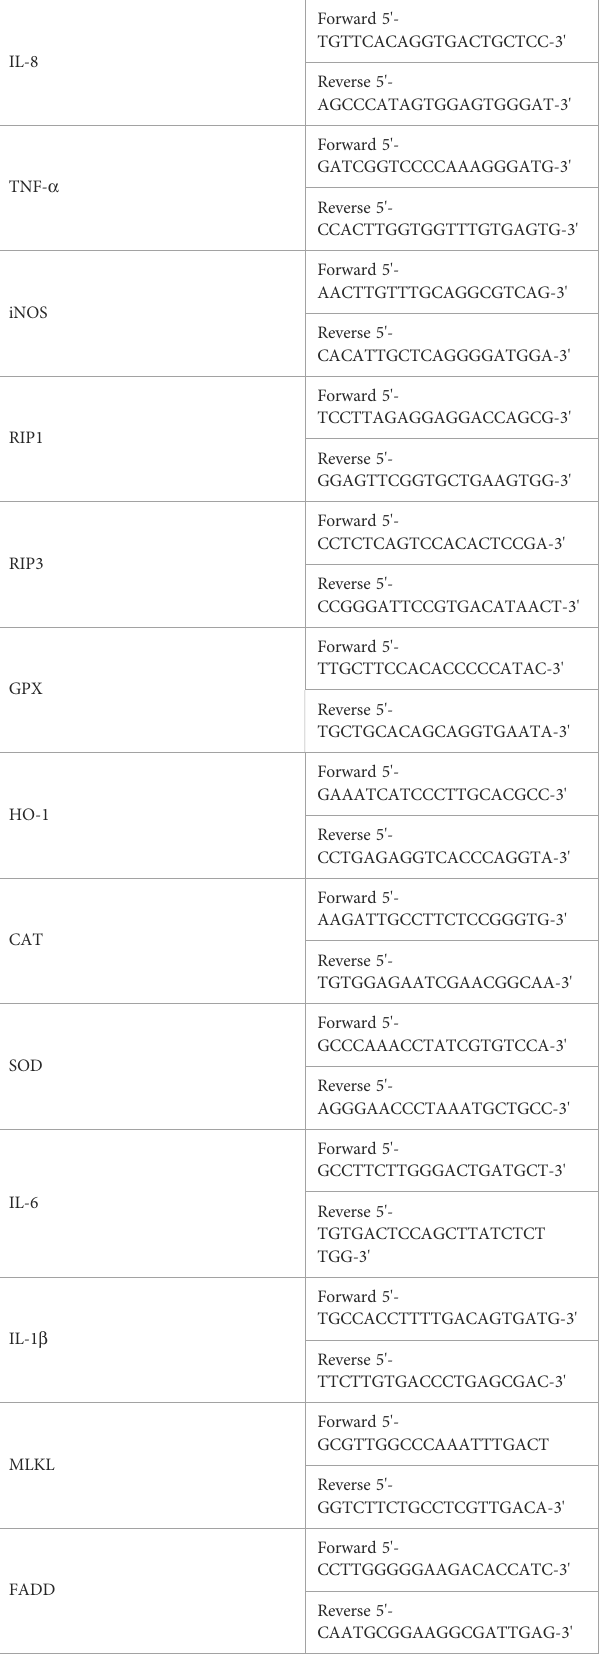
TABLE 1 The primers used in the present